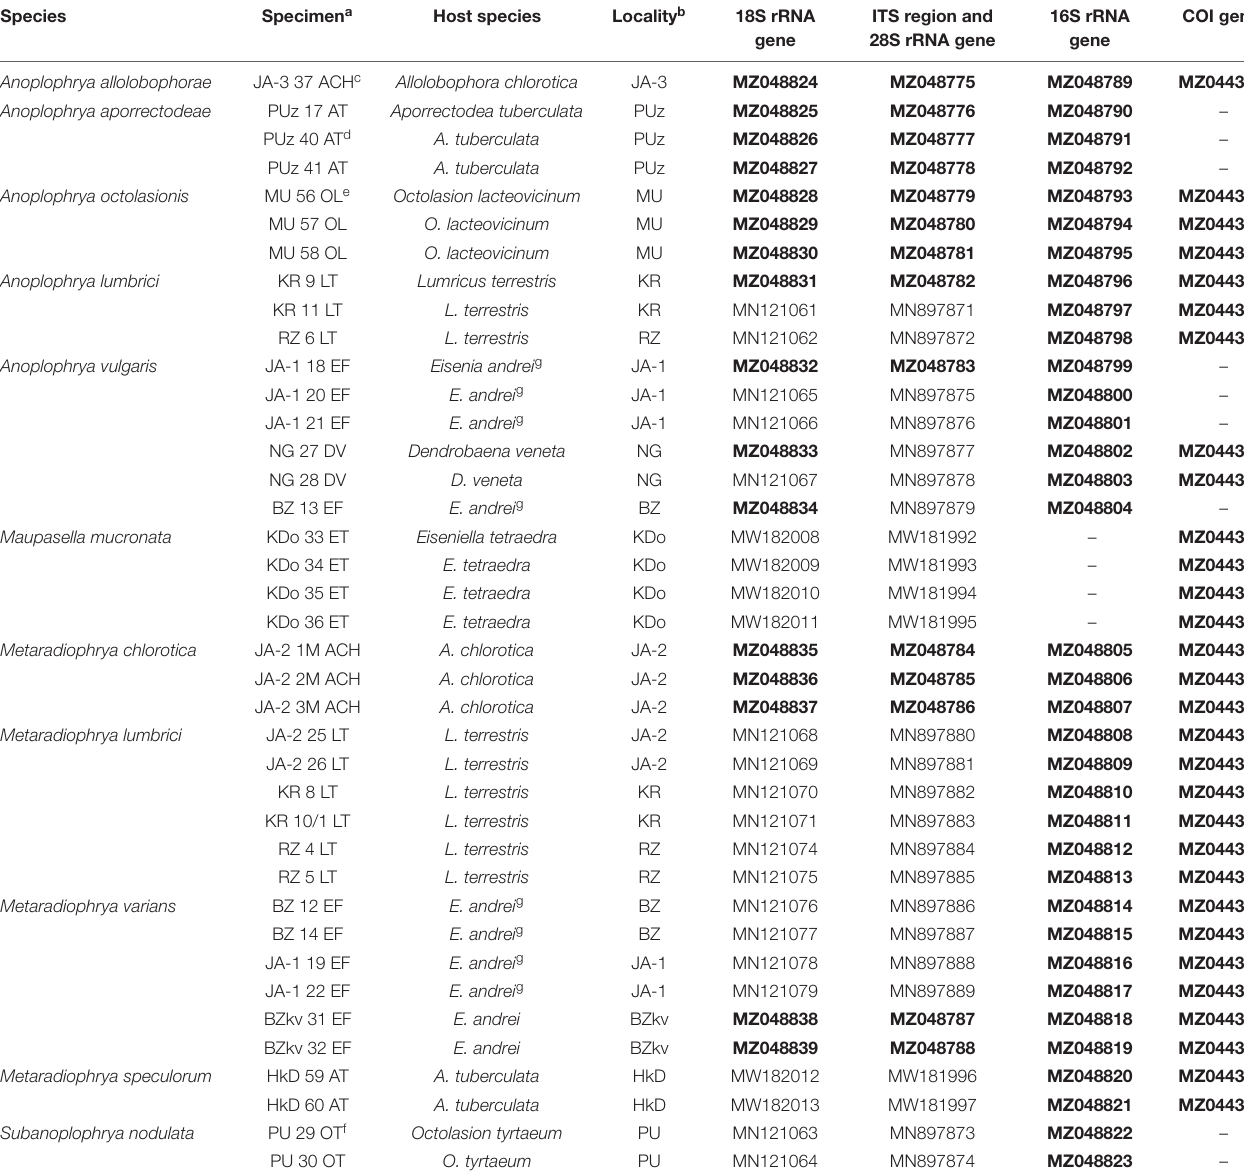
TABLE 1 | Characterization and origin of nuclear and mitochondrial sequences of astome ciliates analyzed in the present